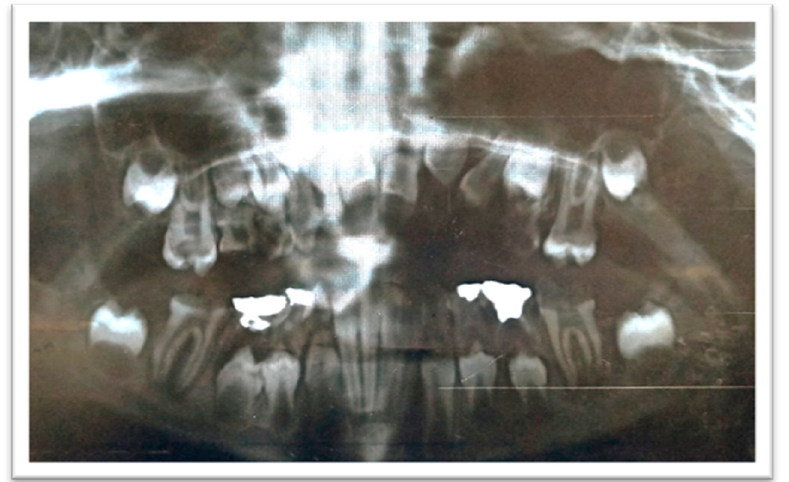
Figure 3. A panoramic radiograph showing teeth #46 and #36 with extremely large carious lesions and periapical radiolucencies, tooth #16 with an extensive carious lesion, and large carious lesions in the upper primary molars.